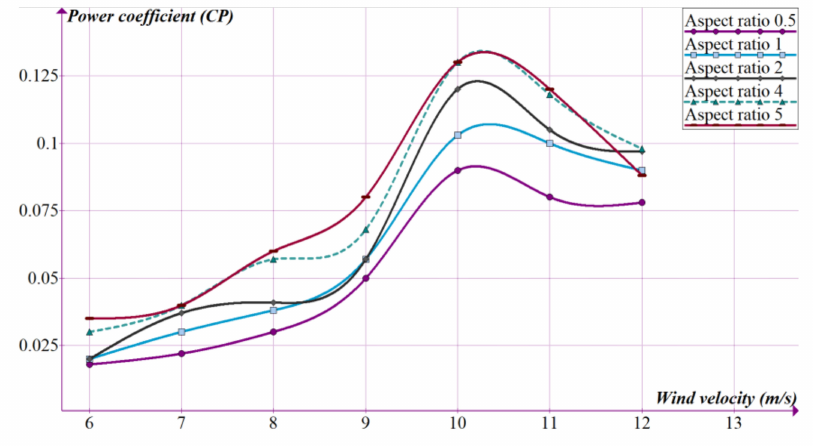
Figure 8. Power coefficient for rotors with different aspect ratio values [72].